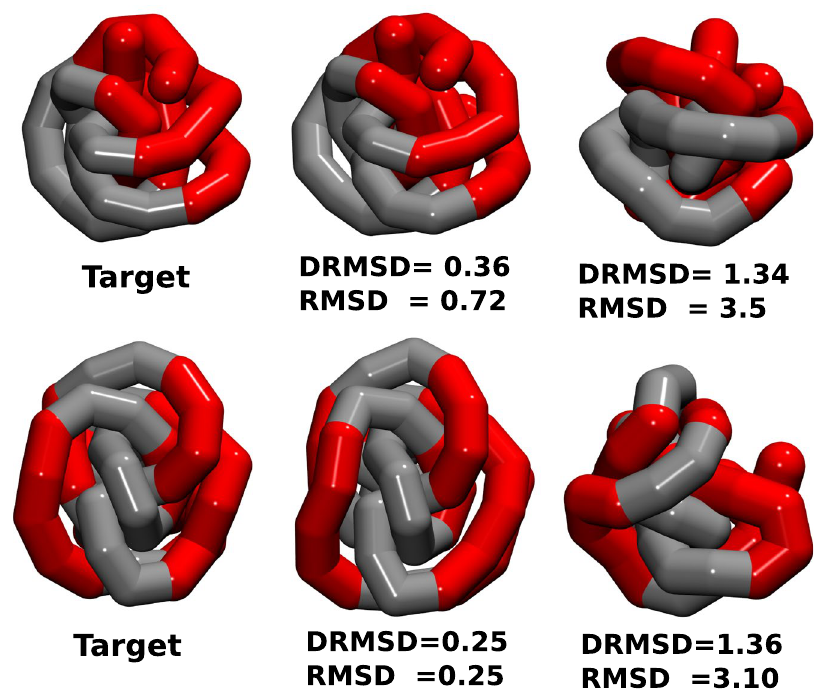
Figure 1. Functionalized patchy polymer structures. Simulation snapshots showing the target structures with the desired functionalizations (left), the final folded structures obtained using our design procedure (centre) and examples of misfolded structures (right), the last two aligned with respect to the correspondent target structure. The values of DRMSD (distance root mean square displacement, see Eq. 3) and RMSD (root mean square displacement see Eq. 4) with respect to the target structure are in units of the bead radius, that for proteins has been seen to correspond to approximately 2 Å, so in protein units the two folded structures would have a RMSD with respect to the target structure in the range 0.5–1.4 Å and the two molten globule structures in the range 6–7 Å. Such functionalized polymers can, in turn, be used as Janus (one-patch) particles (top) or triblock Janus (two patches) particles